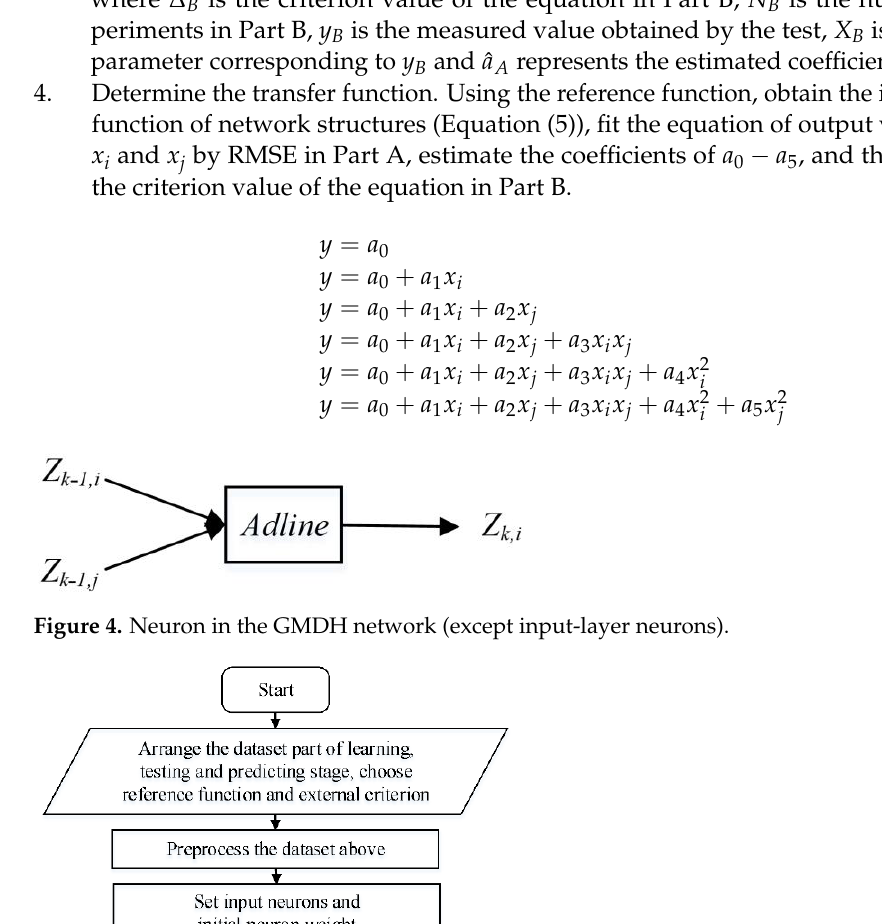
Figure 3. Structure sample of GMDH for surface roughness prediction.